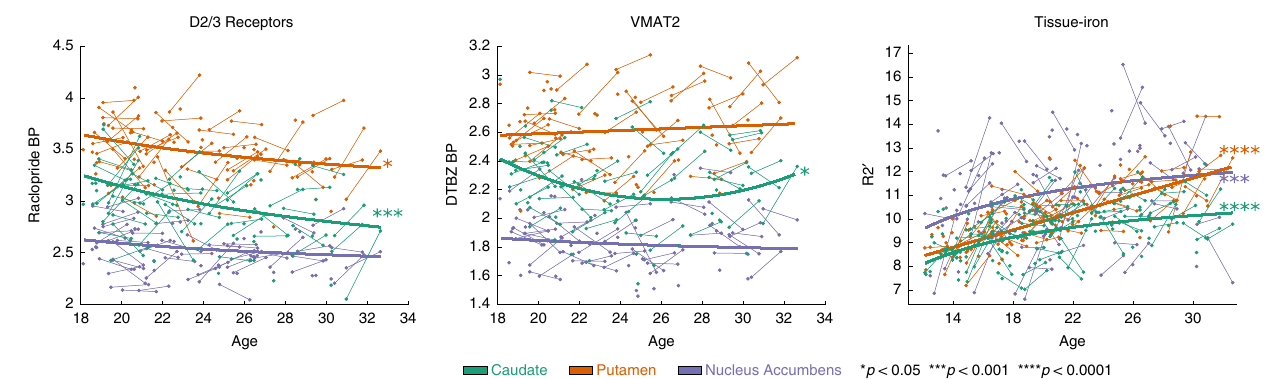
Fig. 1 Developmental effects. Age related-differences in Raclopride assessment of available D2/D3 receptor concentration (N = 78 individuals, 128 sessions; outlier removals: NAcc = 3, putamen = 1, caudate = 1), DTBZ assessment of VMAT2 concentration ( N = 74 individuals, 119 sessions; outlier removals: NAcc = 1, putamen = 2, caudate = 0), and R2 ′ assessment of tissue iron content ( N = 121 individuals, 180 sessions; outlier removals: NAcc = 2, putamen = 1, caudate = 2) in the striatum. All analyses were conducted using linear mixed-effects models. Model parameters can be found in Table 1. + p < 0.05 uncorrected, * p < 0.05, *** p < 0.001, **** p < 0.0001 Bonferroni corrected. DTBZ BP [11C]Dihydrotetrabenazine binding potential; Raclopride BP [11C] Raclopride binding potential. Table 2 Linear mixed effects regression table for associations between R2 ′ and PET binding potentials. PET measure Region